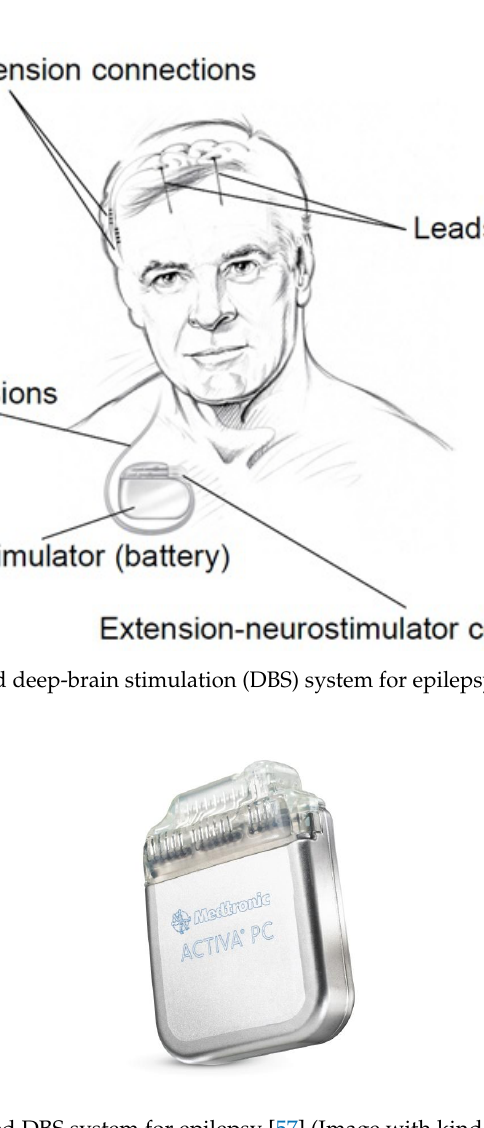
Figure 11. FDA approved DBS system for epilepsy [57] (Image with kind permission of